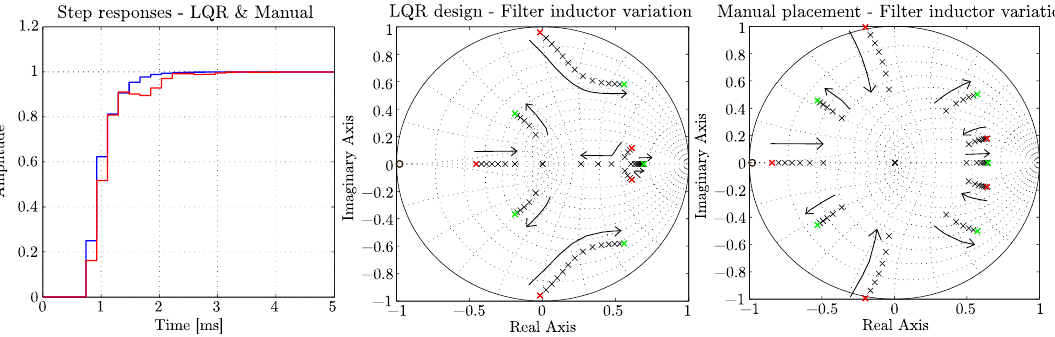
Figure 8. Pole placement alternatives. ( left ) Step response with (blue) manual and (red) linear quadratic regulator (LQR) gain selection. Closed-loop system poles and zeros when the filter inductor varies from − 40% to + 20% for ( center ) LQR and ( right ) manual pole